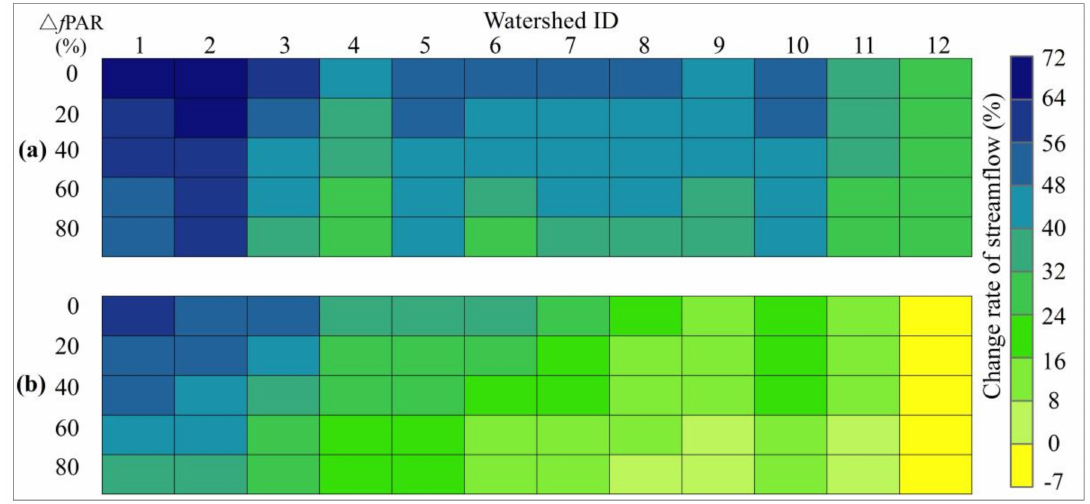
Figure 11. Runo ff change rate for di ff erent regreening scenarios throughout the 12 watersheds for the periods ( a ) 2020–2049 and ( b ) 2050–2099 compared with the period